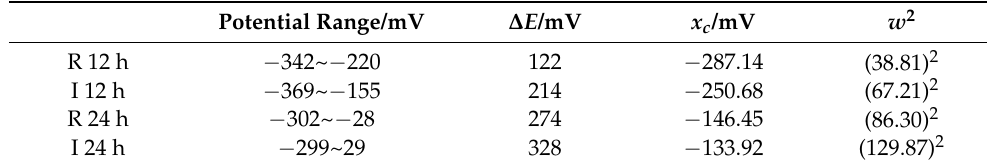
Figure 5. Gaussian fitting curves of pitting corrosion at different times. Table 2. SKP potential and Gaussian fitting